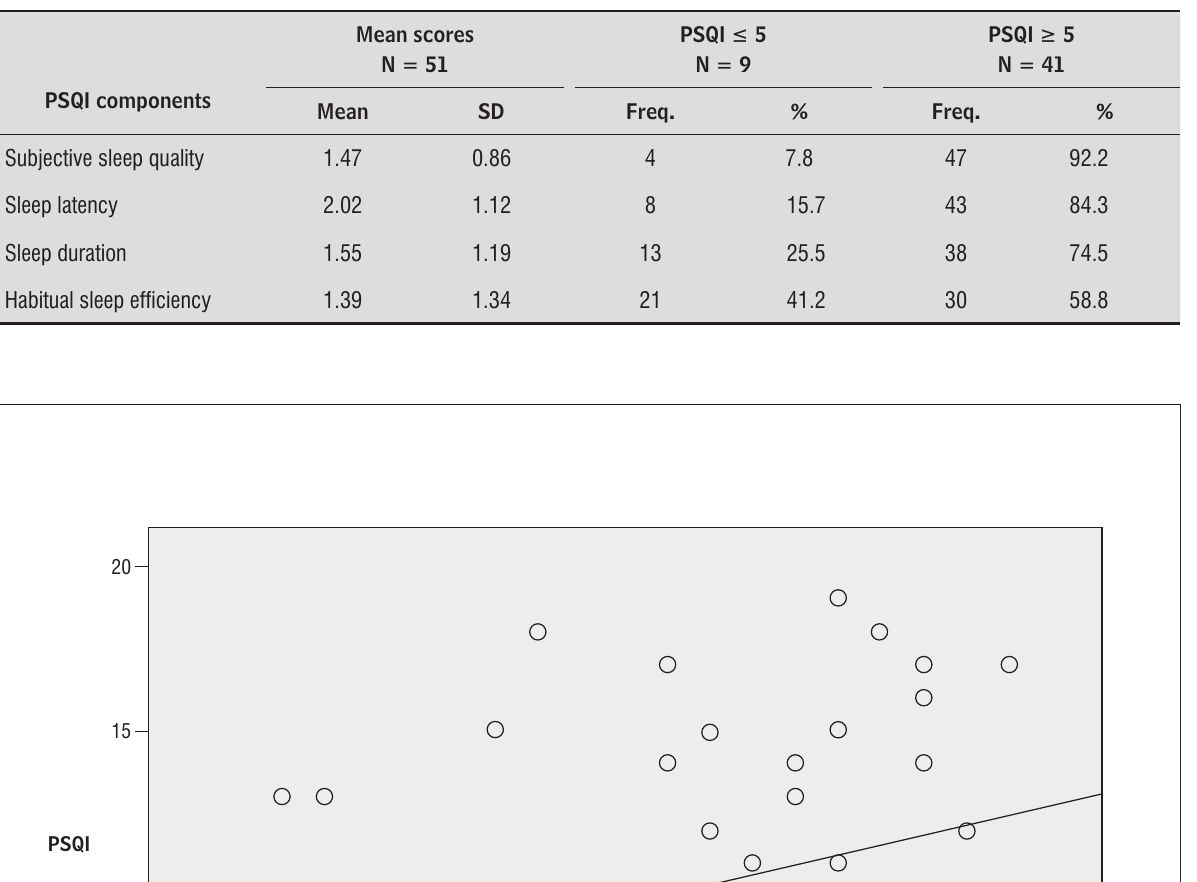
Table 2 - Mean PSQI scores, prevalence of individuals with and without changes in PSQI scores, and mean RMDQ scores